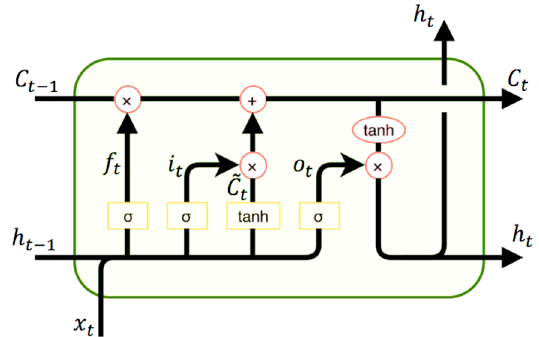
Figure 2. Information flow in an LSTM block of the RNN.